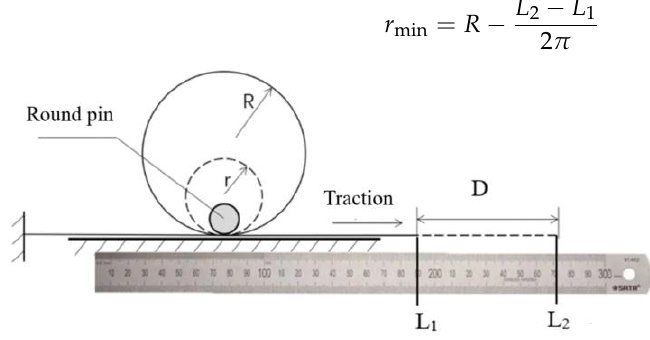
Figure 4. Measuring method of the minimum curvature radius.